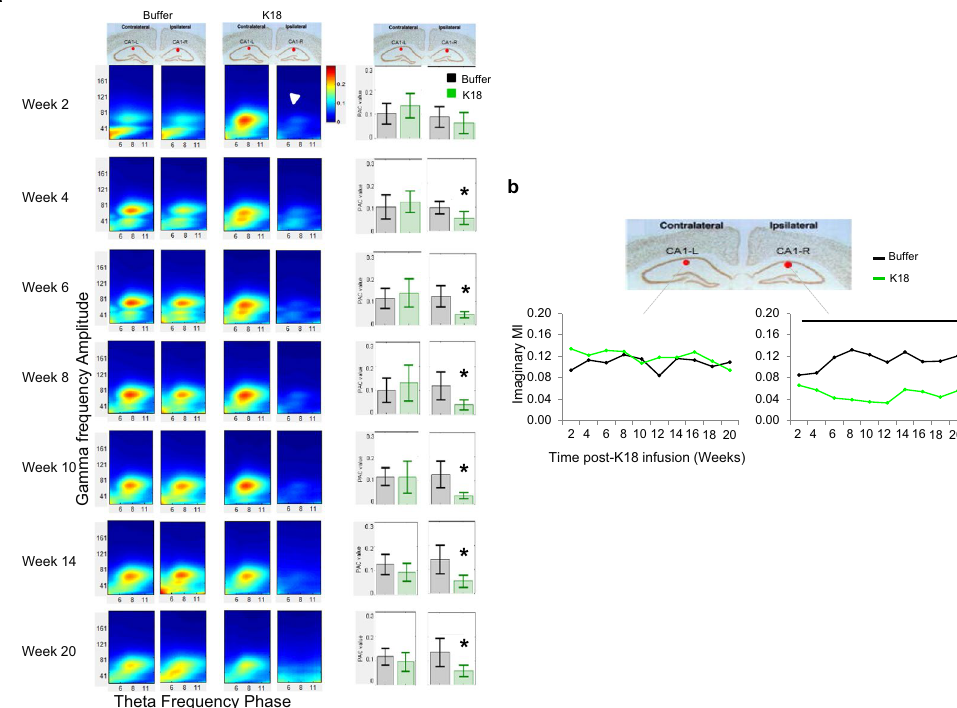
Figure 4. Representative comodulation Phase-Amplitude maps showing early deficit in theta-gamma phase- amplitude coupling during waking state in recordings from the hippocampal CA1 of K18-treated mice. (a) Bar panels represent mean modulation index (MI) values ± SEM in mice injected with K18 (green) and buffer (black) showing a significant decreased in coupling strength for K18 infused animals as revealed in theta- gamma MI (p < 0.05). ( b) Time course of mean MI showing some sustained impairments in the strength of theta-gamma phase-amplitude coupling from the right HPC CA1 of K18 group (green, n = 8) as compared to buffer (black, n = 9) groups. 3 animals across different conditions were discarded from the analysis because of signal